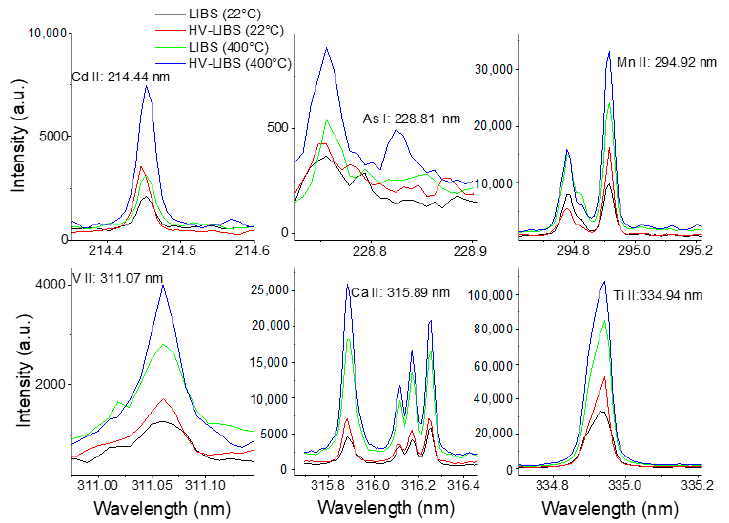
enhancement of the detection limit.